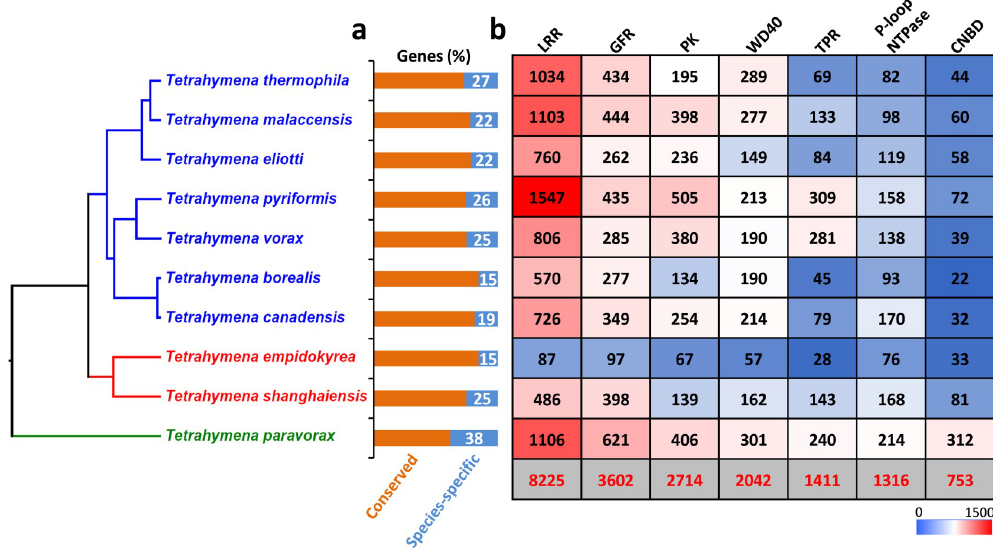
Fig 2. Top gene domains that contribute to the high MAC genome divergence in the 10 species. (a) Percentage of species-specific genes in each species. (b) Heat map of the top 7 categories of domains found in species-specific genes: the bottom row (gray background) shows the total number of genes containing each domain category in all 10 species. CNBD, cyclic nucleotide-binding; GFR, growth factor receptor cysteine-rich; LRR, leucine-rich repeat; MAC, macronucleus; P-loop NTPase, P-loop-containing nucleoside triphosphate hydrolase; PK, protein kinase; TPR, tetratricopeptide repeat; WD40, WD40 repeat.